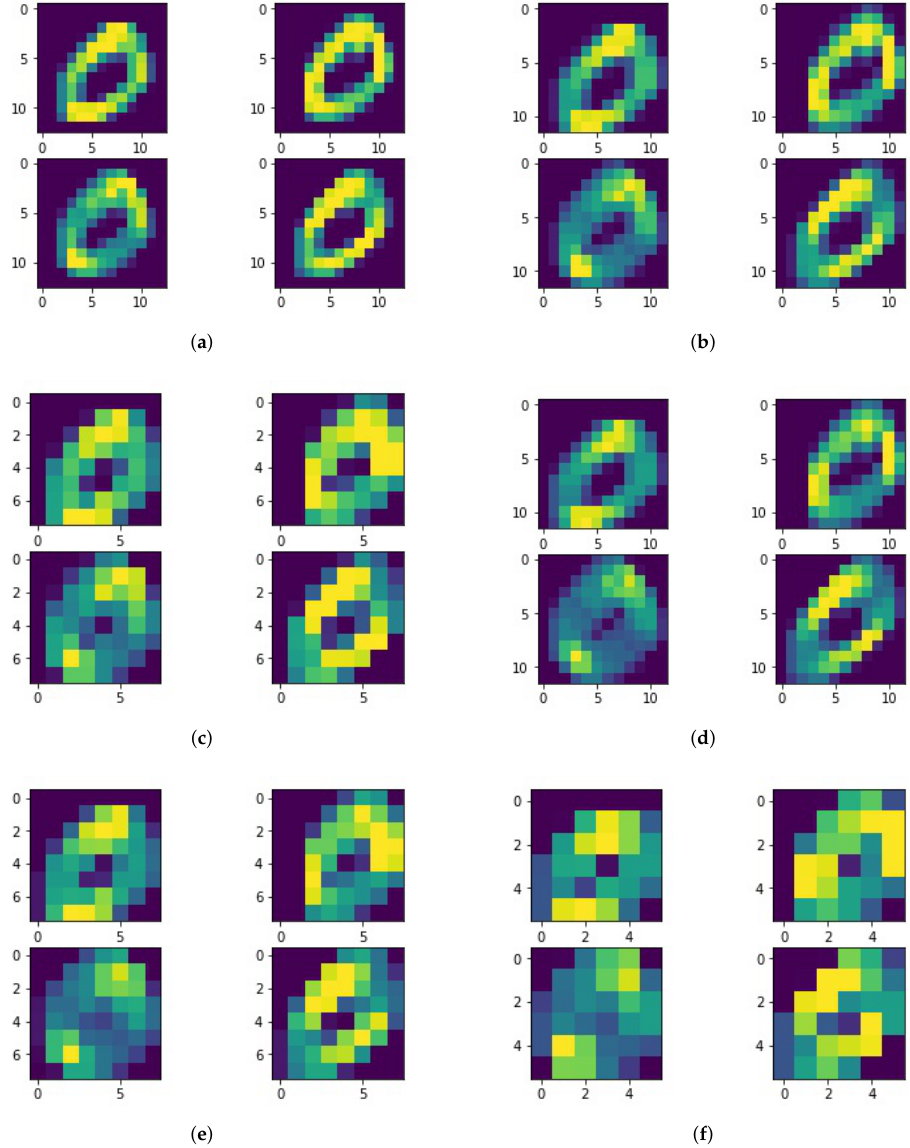
Figure 7. Effect of feature extraction after convolution and pooling. ( a ) 3 × 3 convolution kernel and 2 × 2 pooling; ( b ) 4 × 4 convolution kernel and 2 × 2 pooling; ( c ) 4 × 4 convolution kernel and 3 × 3 pooling; ( d ) 5 × 5 convolution kernel and 2 × 2 pooling; ( e ) 5 × 5 convolution kernel and 3 × 3 pooling; ( f ) 5 × 5 convolution kernel and 4 × 4